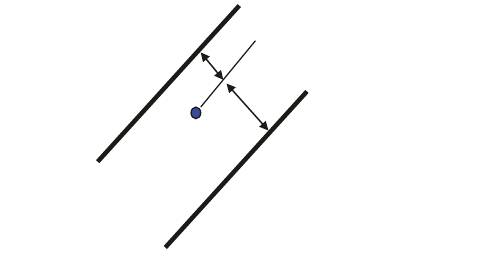
Figure 24: The sketch map of well A. This gas reservoir was controlled by two faults.